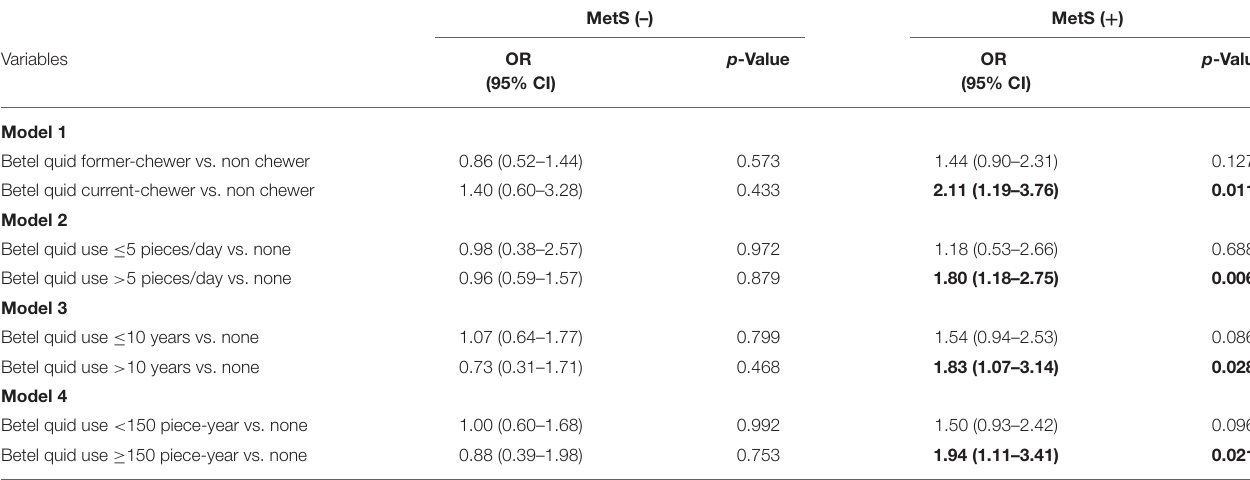
TABLE 3 | Logistic regression model for significant liver fibrosis (NFS ≥ -1.455) among patients with and without metabolic